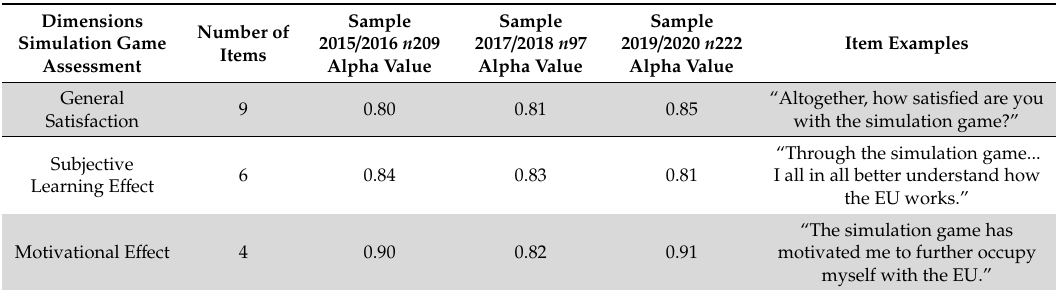
Table 2. Measurement Model of Simulation Game